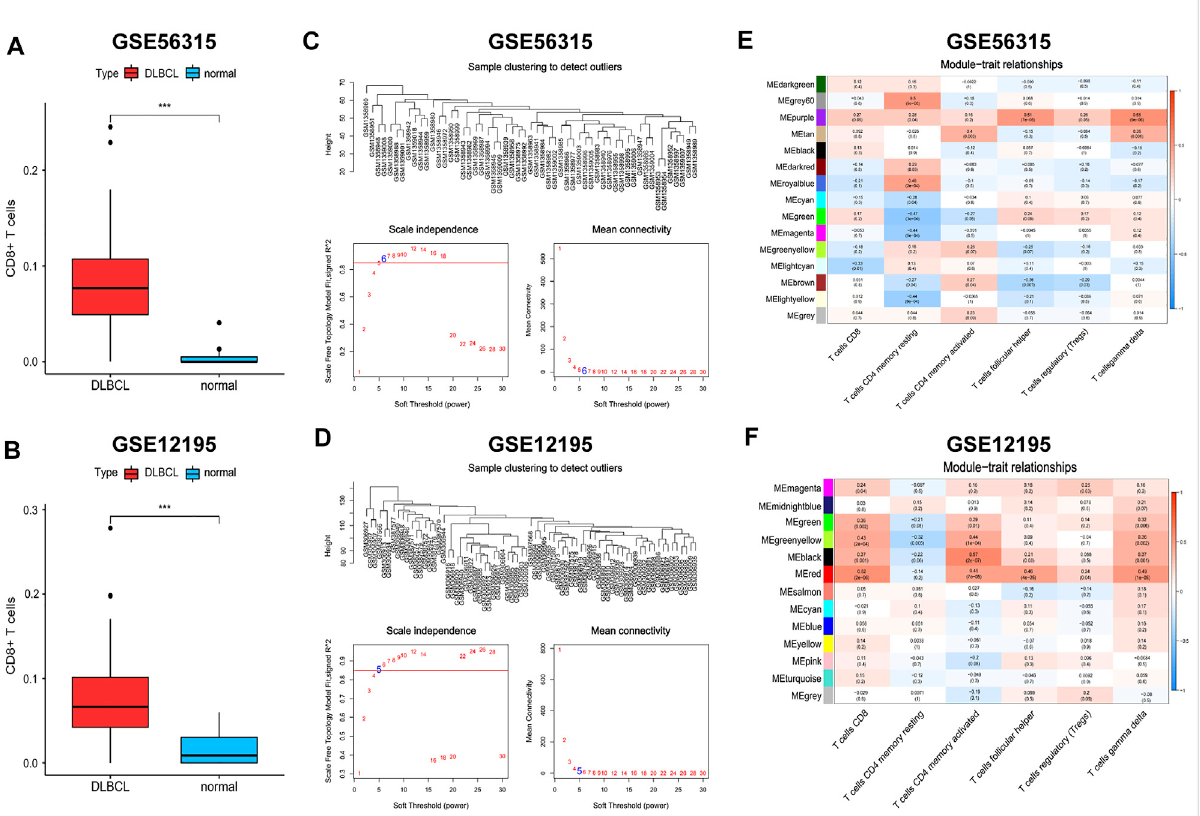
FIGURE 7 Weighted gene coexpression network analysis (WGCNA). (A,B) The distribution differences of CD8 + T cells between DLBCL and normal patients. (C,D) Topological network analysis of the optimal soft threshold. (E,F) Identi fi cation of weighted gene co-expression network modules associated with CD8 + T cells. Wilcoxon test for comparison of CD8 + T cells distribution between DLBCL and normal patients. *** p <